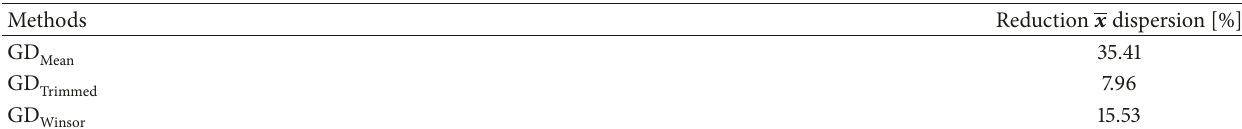
Table 73: G-h with 1000 points.